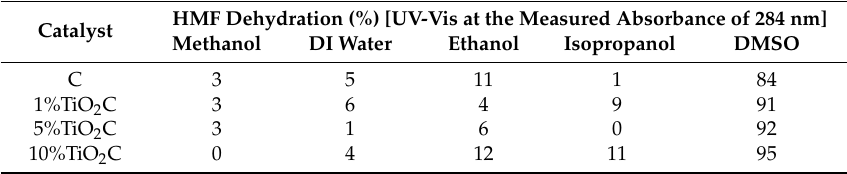
Table 2. Dehydration of fructose in different solvents.